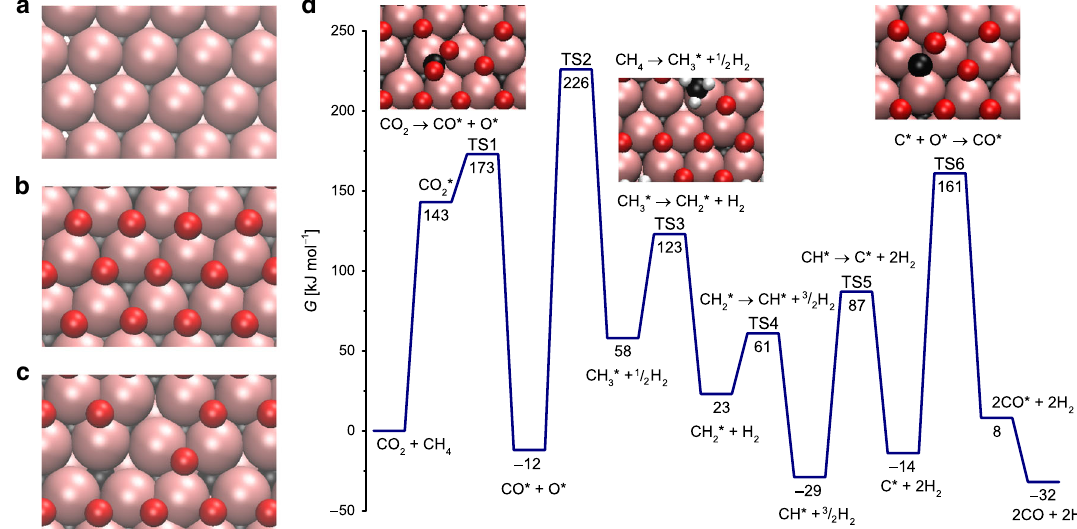
Fig. 3 Theoretical modeling of DRM pathways. Top view of the a clean 2D-Mo 2 C, b 2D-Mo 2 C-1 O ML and c 2D-Mo 2 C-0.67 O ML surfaces. d Gibbs free energy pro fi le of the dry reforming of methane catalyzed by the 2D-Mo 2 C-0.67 O ML surface. Gibbs energies are given with respect to initial reactants, CH 4 and CO 2 , at 800 °C and under 1 bar pressure. For brevity, the reaction pro fi le is presented without H – H coupling steps. The full pro fi le is shown in Supplementary Fig. 25. TS stands for transition